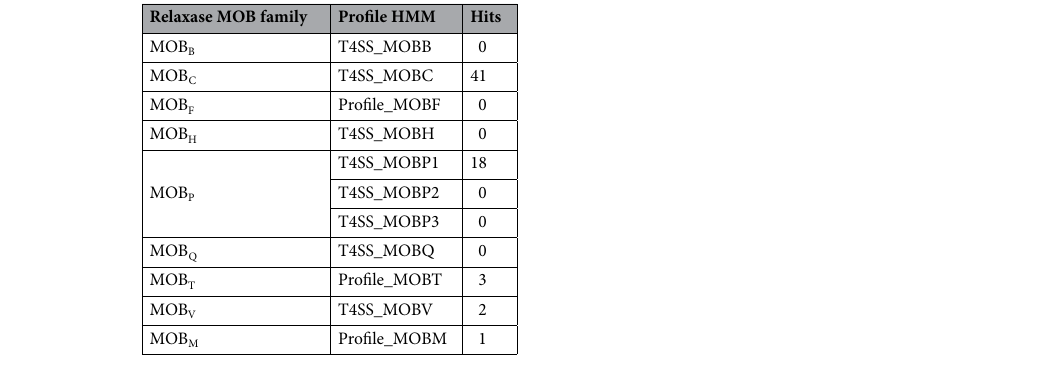
Table 2. Relaxase MOB families in the Diamante Lake